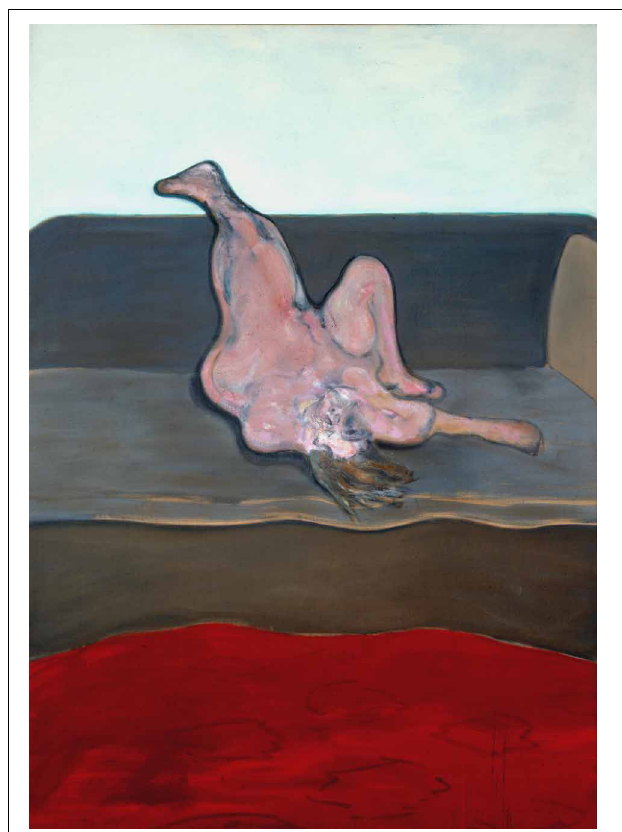
FIGURE 5 | Francis Bacon— Reclining Woman, 1961. © The Estate of Francis Bacon. All rights reserved. DACS 2013.